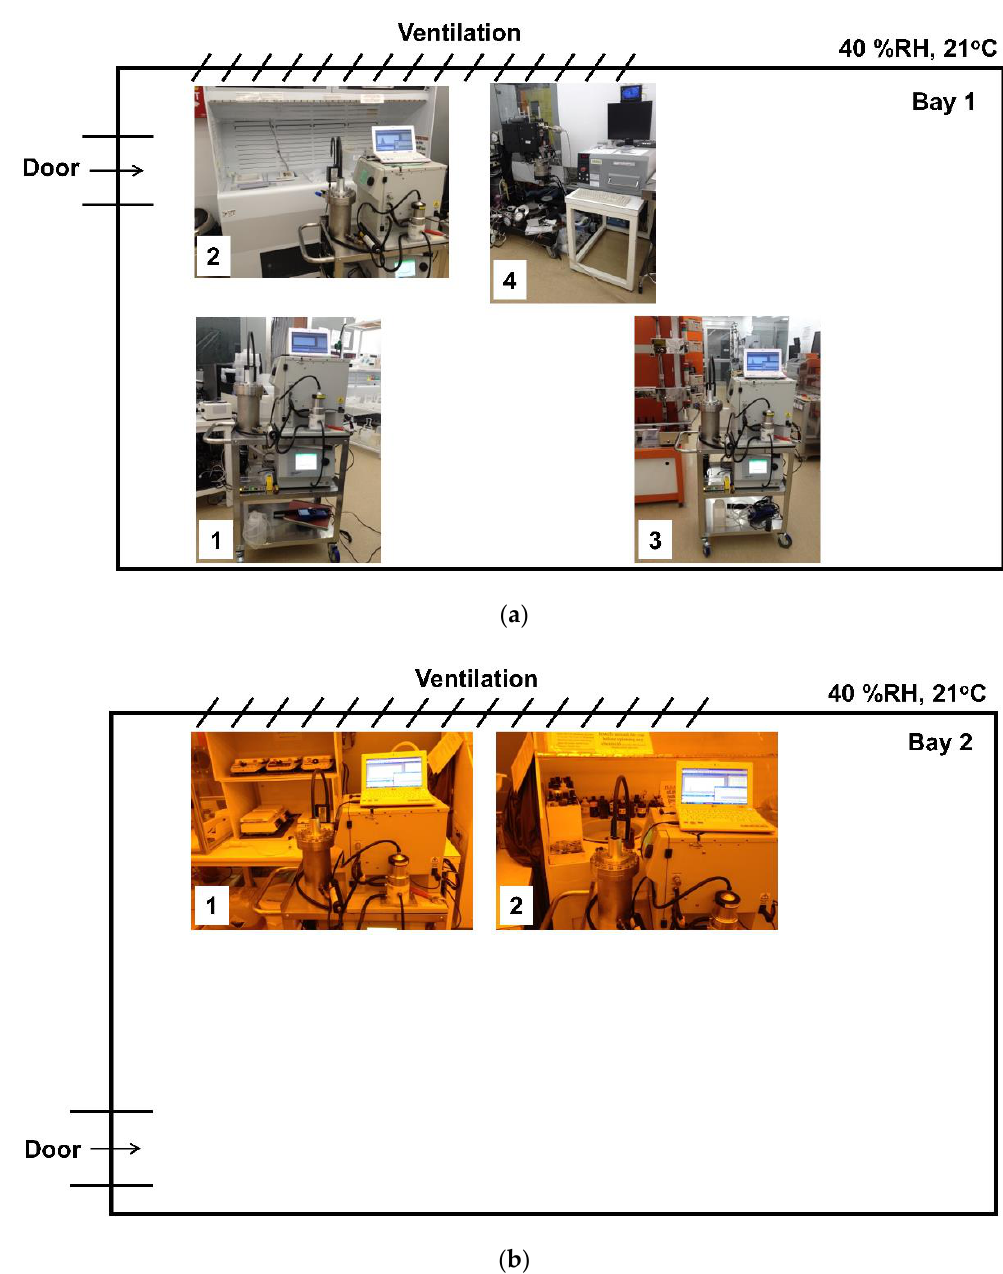
Figure 2. Details of the sub-locations as the monitoring sites for AMC in ( a ) Bay 1 and ( b ) 2 of the cleanroom at the University of Minnesota. The cleanroom air was well conditioned at 40% relative humidity (RH), 21 o C